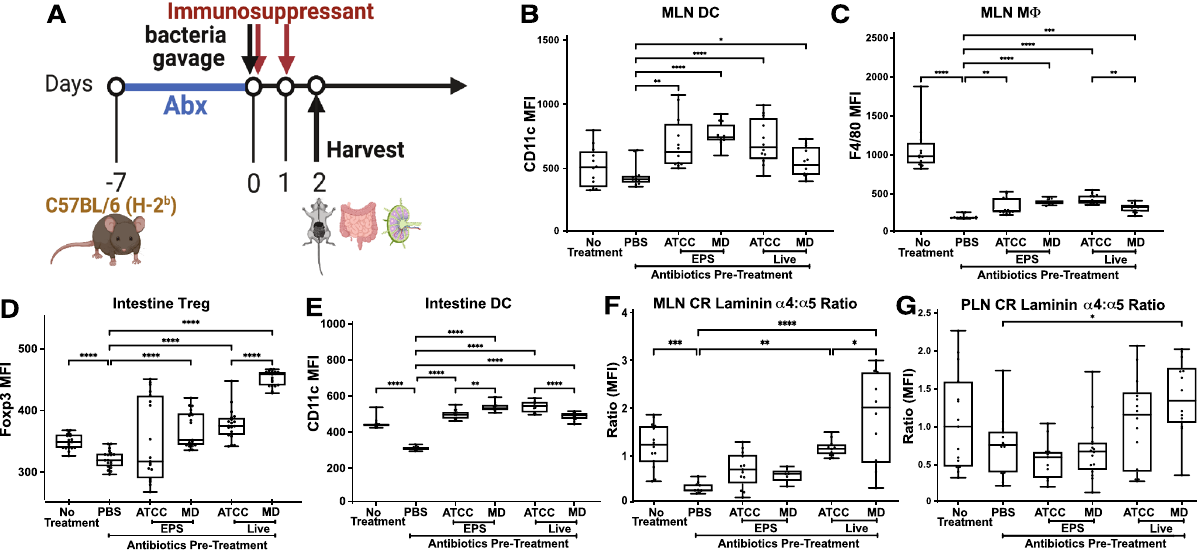
Figure 3. Bifidobacterium strains induce unique changes in local and systemic immune cell distribution and LN architecture. ( A ) Experimental design. C57BL/6 mice treated with antibiotics for 6 days followed by oral gavage with B. pseudolongum ATCC25526 (ATCC), UMB-MBP-01 (MD), or PBS (control). Mice then treated with the immunosuppressant tacrolimus for the next two days. Tissues harvested 2 days after oral gavage